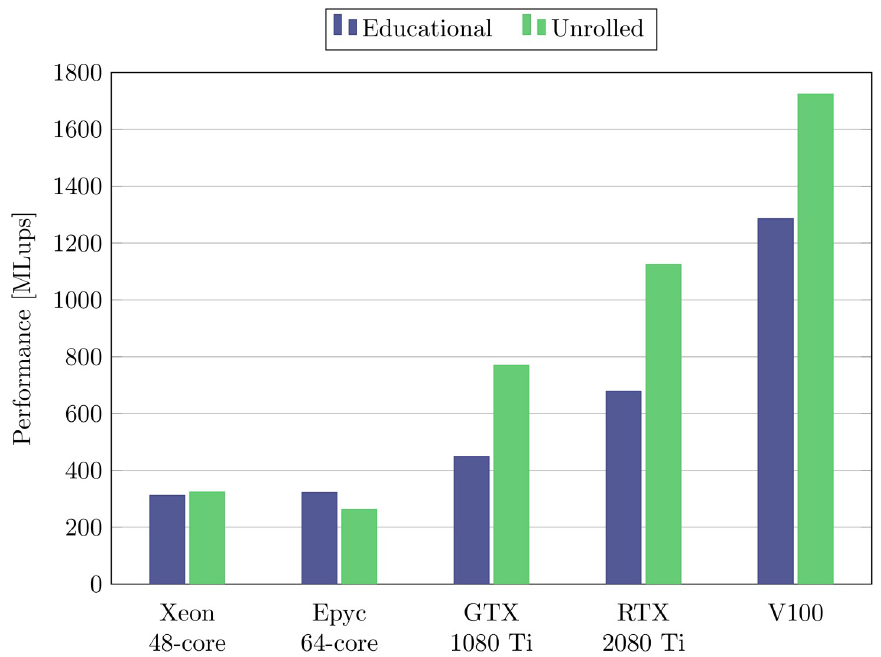
Fig 5. Influence of loop unrolling. All simulations are executed with the BGK-W2 collision model, with the AA-soa scheme, and with N = 128.